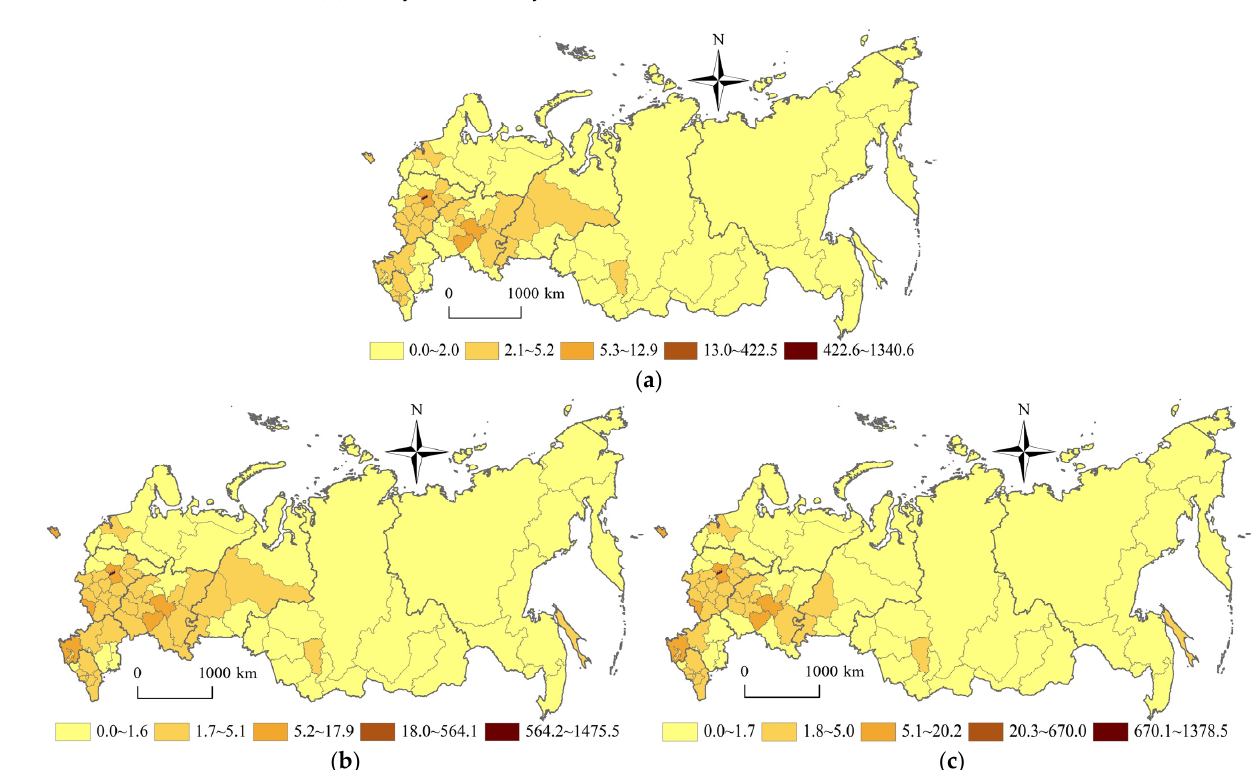
Figure 4. Spatial pattern of Russia’s economic concentration degree during 2002–2020. ( a ) 2002 year ( b ) 2010 year ( c ) 2020 year.